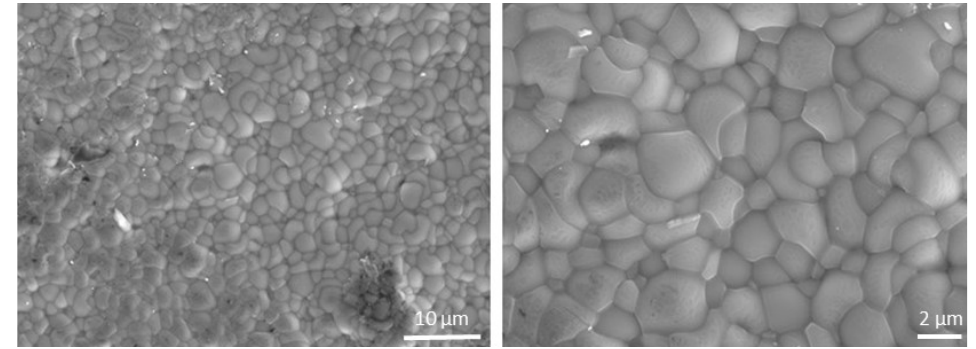
Figure 4. Secondary electron micrographs of the surface of the BCZY27 electrolyte from a co-sintered BCZY27-NiO/BCZY27 tube.